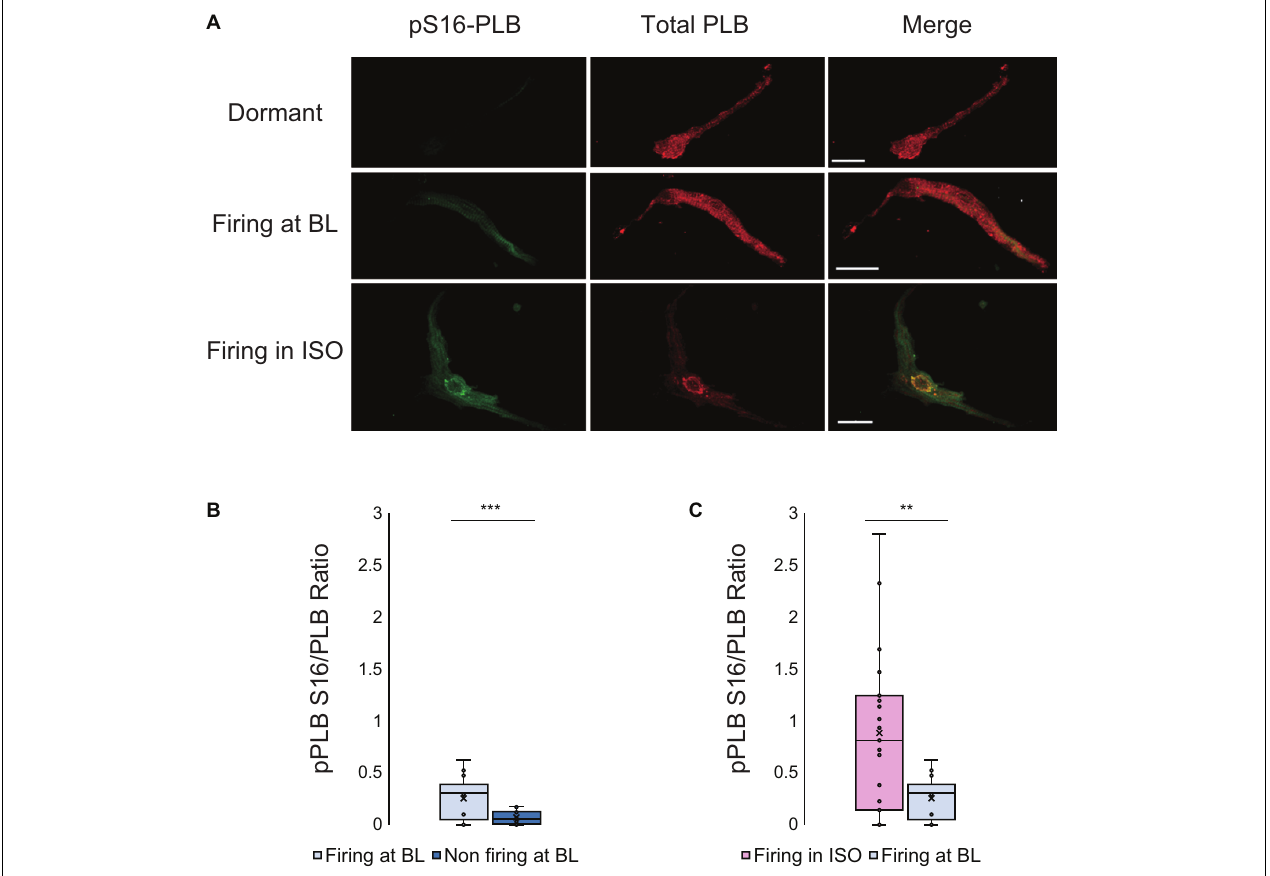
FIGURE 2 | (A) Double immunolabeling of phosphorylated phospholamban (p-PLB) at Serine 16 (green) and total PLB (red) and the merged images of SANC that were dormant at baseline (top), firing at baseline (middle) and dormant at baseline but began firing in response to isoproterenol (bottom). (B) The p-PLB/total PLB ratio of SANC firing at baseline ( N = 3/ n = 10) vs dormant at baseline ( N = 3/ n = 10) (At baseline, firing cells have much higher pPLB S16/PLB ratio than non-firing cells)] and (C) The p-PLB/total PLB ratio of SANC firing in isoproterenol ( N = 5/ n = 15) vs firing at baseline ( N = 3/ n = 10) (Firing cells in ISO have higher pPLB S16/PLB ratios than firing cells at BL). t -test, *** p < 0.001, ** p <